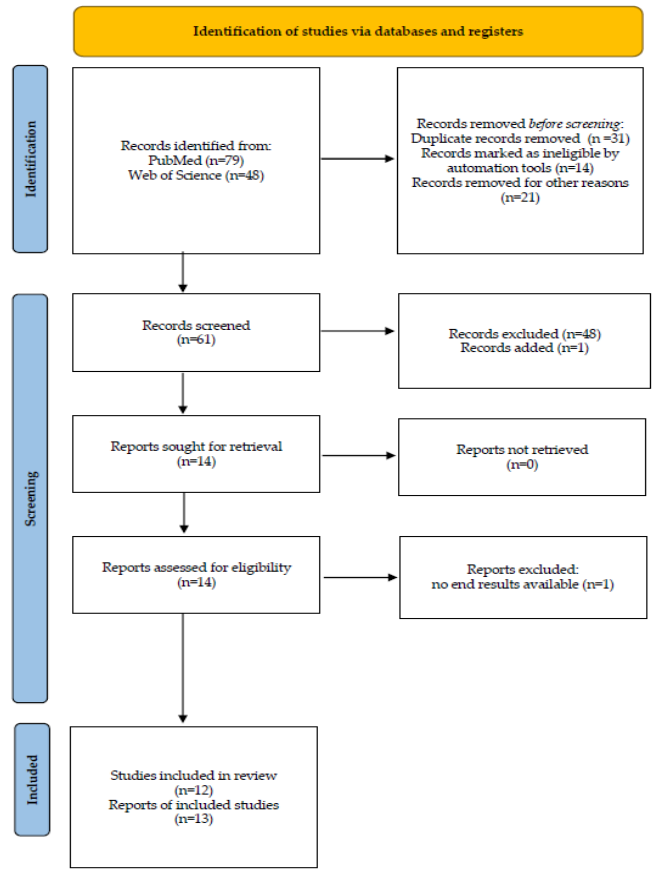
Figure 1. Flow chart of the study.